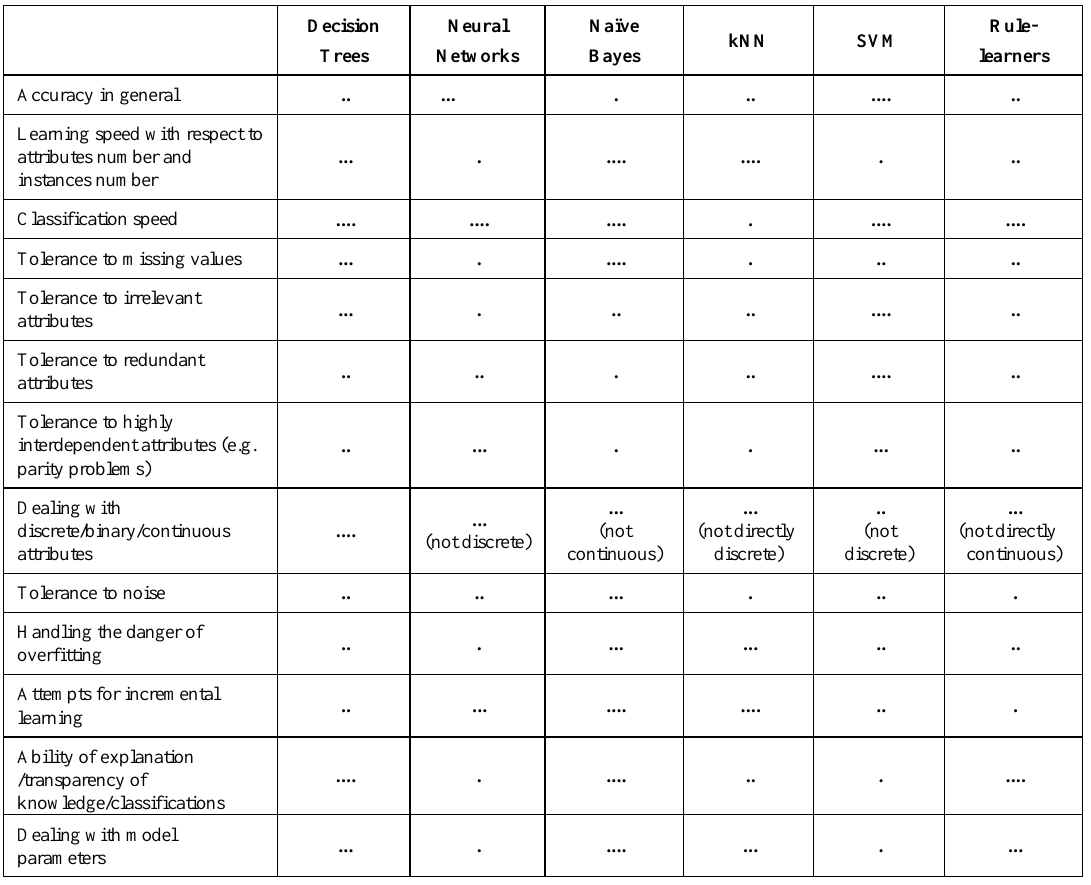
Table 2. Comparison of machine learning algorithms (.... dots represent the best performance; . dot represents the worst